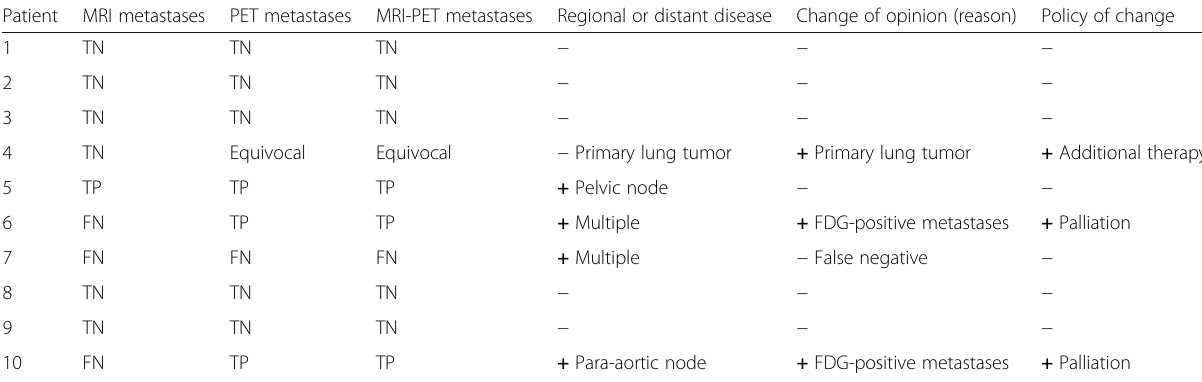
Table 4 Metastases based on MRI (radiologist), PET (nuclear physician), PET-MRI (consensus radiologist and nuclear physician), and the reference standard, and change of opinion and policy Patient MRI metastases PET metastases MRI-PET metastases Regional or distant disease Change of opinion (reason) Policy of